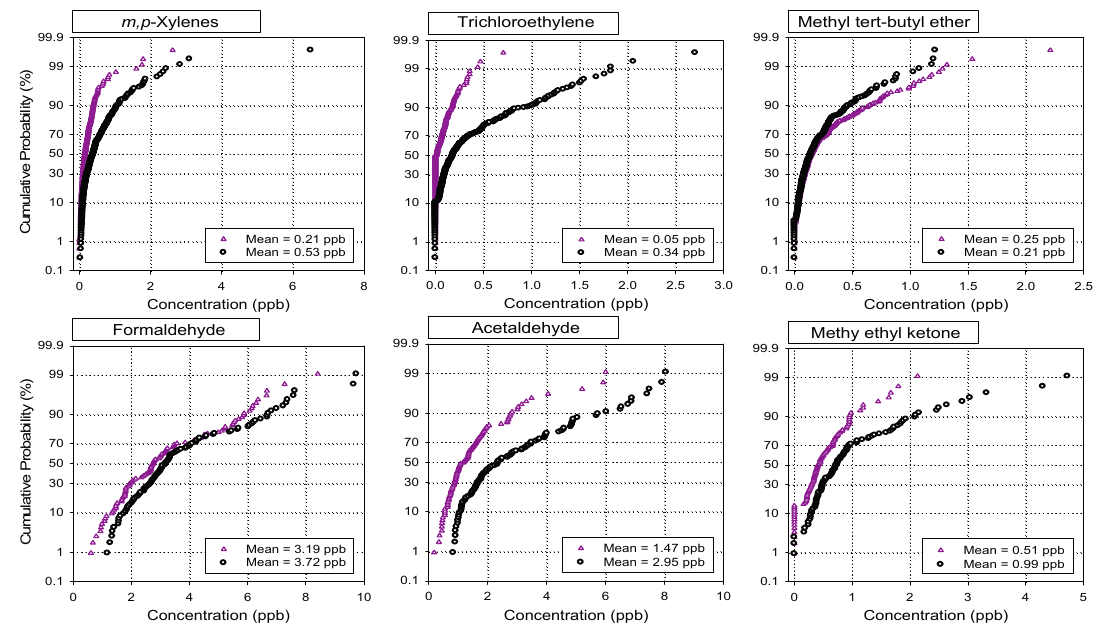
Figure 3. Comparison of the concentration distributions of selected VOCs in industrial (circle dot) and non-industrial areas (triangle dot) for the first campaign during